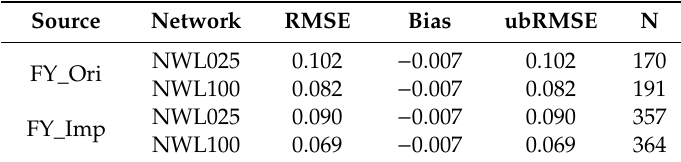
Table 2. Error metrics of FY_Ori SM and FY_Imp SM against the in situ observations. RMSE (root mean square error), Bias (mean bias) and ubRMSE (unbiased RMSE) are all in cm 3 cm − 3 , N is the number of samples.